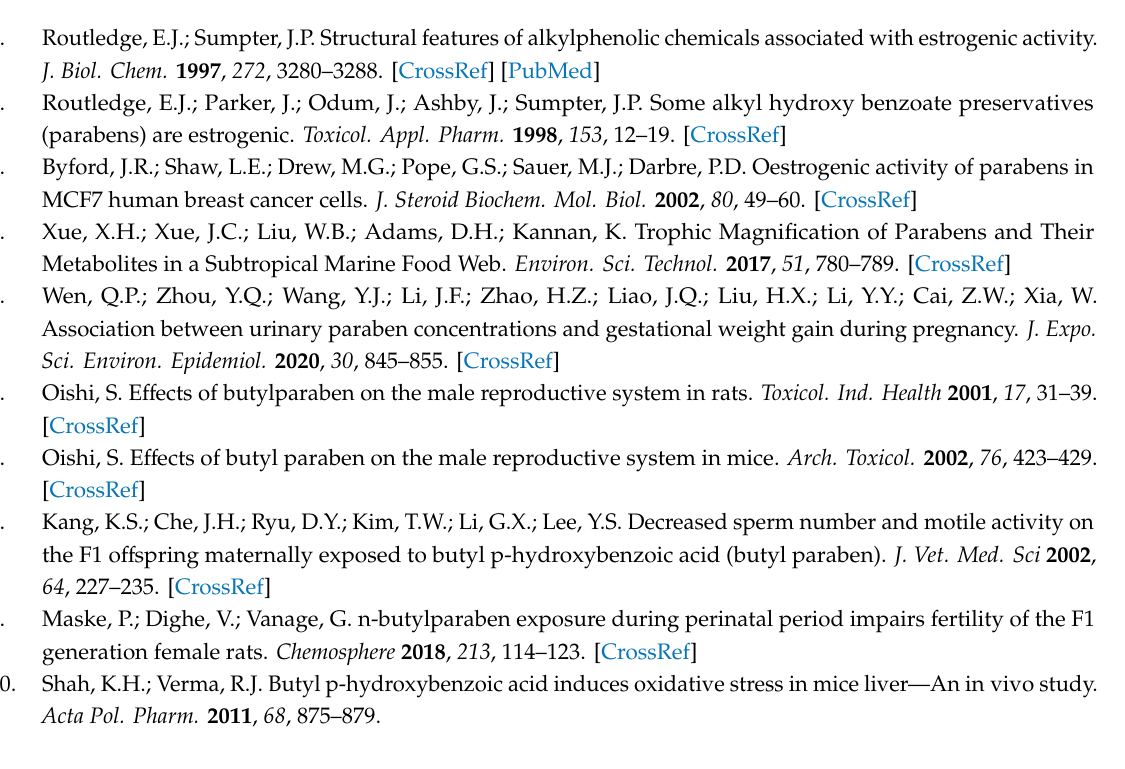
Table S1: M, SD, and univariate e ff ects of di ff erent antioxidant enzymes and GSH / GSSG ratio by concentration in the liver. The results with di ff erent letters mean they are statistically di ff erent from each other ( p < 0.05). Table S2: M, SD, and univariate e ff ects of di ff erent antioxidant enzymes and GSH / GSSG ratio by concentration in the kidney. The results with di ff erent letters mean they are statistically di ff erent from each other ( p < 0.05). Table S3: M, SD, and univariate e ff ects of di ff erent antioxidant enzymes and GSH / GSSG ratio by concentration in the heart. The results with di ff erent letters mean they are statistically di ff erent from each other ( p < 0.05). Table S4: M, SD, and univariate e ff ects of di ff erent antioxidant enzymes and GSH / GSSG ratio by concentration in the seminal vesicles. The results with di ff erent letters mean they are statistically di ff erent from each other ( p <